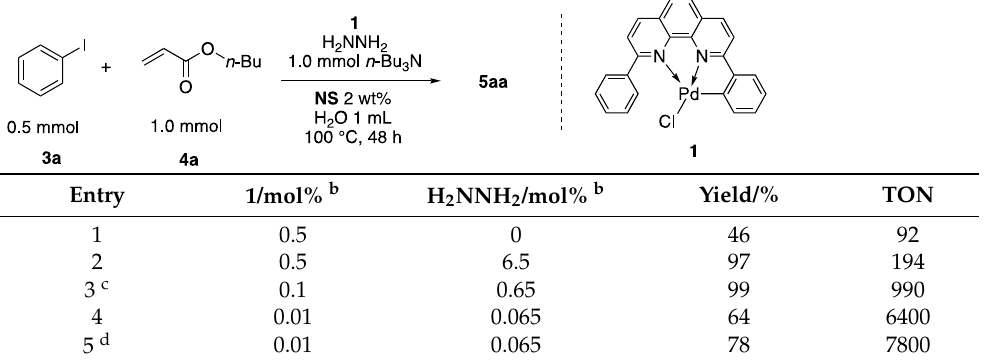
Table 2. Mizoroki–Heck reaction in water with 1 a .